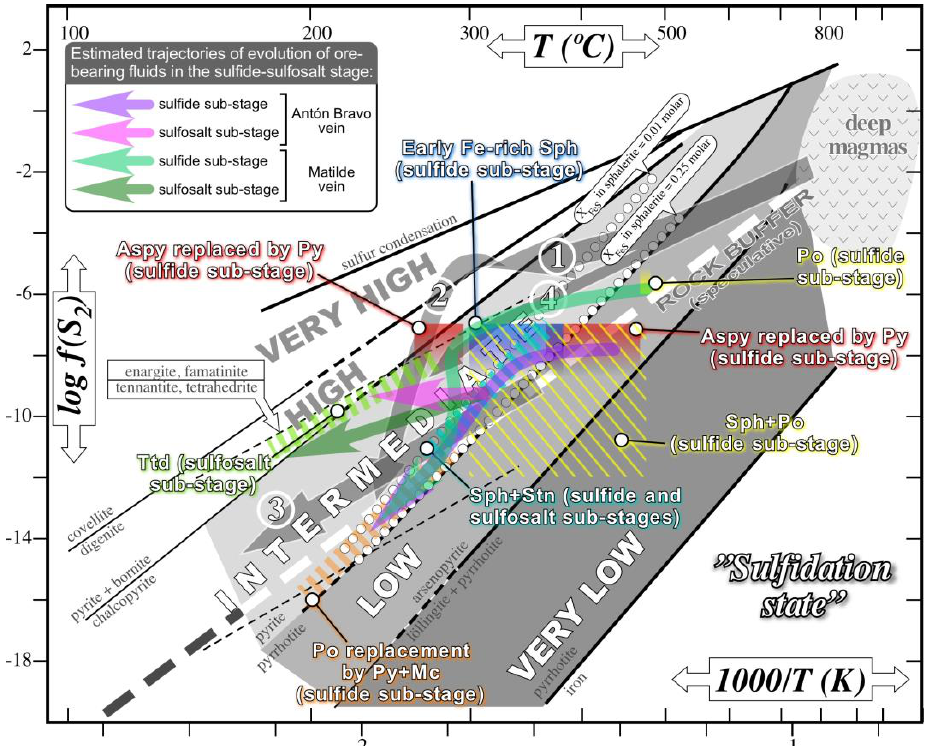
Figure 16. Diagram correlating temperature and sulfur fugacity for the sulfidation states of hydrothermal fluids in the formation environments of porphyry and epithermal deposits, defined according to the stability fields of key minerals, with the approximate sulfidation paths determined by the metallic mineral associations in the sulfide – sulfosalt stage at the Huari Huari deposit (in purple and pink). The lines dotted in white represent the sulfidation curves for common contents of FeS in sphalerite, deduced from Figure 5 in Einaudi et al. [66] and adopted from Camprubí and Albinson [67]. The sulfidation trajectories determined for the sulfide and sulfosalt substages were constructed by using the mineral sequence determined in Figure 7 and the key interrelationships between minerals as follows: (1) arsenopyrite replacement by pyrrhotite, (2) coprecipitation of sphalerite and stannite, (3) replacement of pyrrhotite by pyrite and marcasite ("bird's eye" textures), and (4) precipitation of tetrahedrite after stannite. Trajectories 1, 2, and 3 (in white, in circles) are those described for porphyry copper deposits, base- metal veins associated to porphyries (or “looping path” of magmatic fluids), and active geothermal fluids (or “geothermal path”), respectively, according to Einaudi et al. [66]. Trajectory 4 (in white, in a circle) is a speculative “flattened looping path” that aims to explain the sulfidation trajectories deduced for Mexican epithermal deposits, according to Camprubí and Albinson [67]. The general diagram and the information it bears was largely adapted from Einaudi et al. [66] and Sillitoe and Hedenquist [68]. The areas in which the depicted reactions were deduced to take place, as deduced in this paper, were determined as follows: (1) The boxes in red and deep blue and yellow that fade downward do so from the maximum value of sulfur fugacity that was obtained in this study. Similarly, the yellow box that fades upward does so from the minimum value of sulfur fugacity that was obtained in this study. The box striped in yellow denotes the case in which maximum and minimum values for sulfur fugacity are available. (2) The boxes striped in light blue, orange, and green were positioned below or above the stability limit for the characteristic minerals or reactions to which they referred (orange for the replacement of pyrrhotite by pyrite and marcasite, green for tetrahedrite) or the approximate FeS content in sphalerite that coprecipitated with stannite (light blue). The length of these boxes was determined by the range of temperatures at which the depicted reactions were determined to occur as of this study. Key: Aspy = arsenopyrite, Mc = marcasite, Po = pyrrhotite, Py = pyrite, Sph = sphalerite, Stn = stannite, and Ttd =